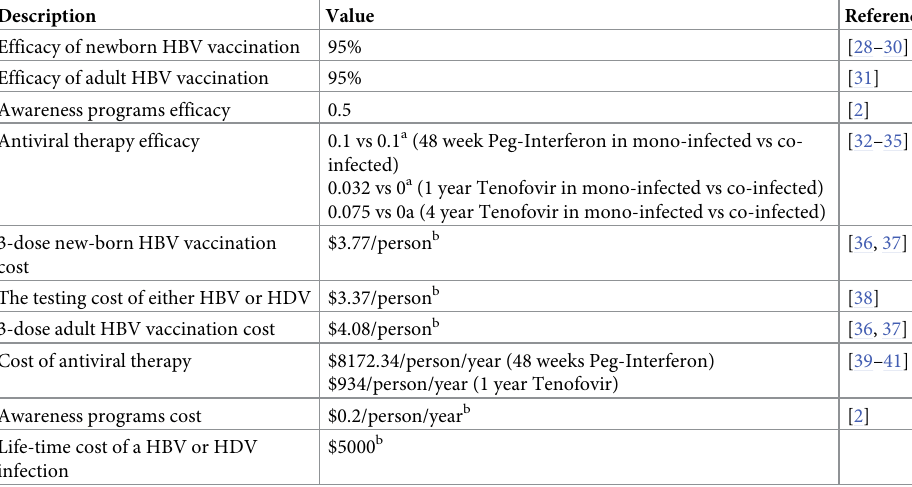
Table 1. Cost (in US dollars) and efficacy of five interventions in 2017.